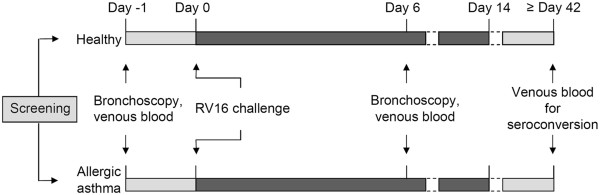
Study design (adapted from ref. [21]).